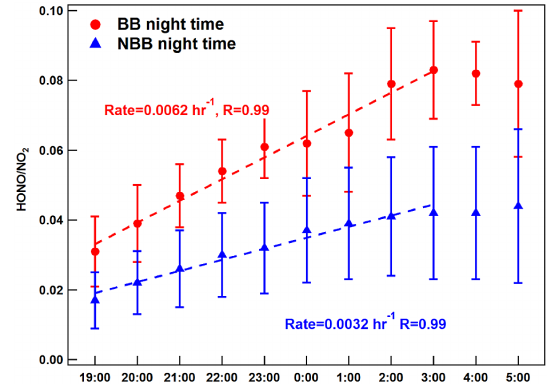
(except for the 10 June case) and non-BB plumes. The change rates were calculated from 19:00 to 02:59. Error bars are the standard